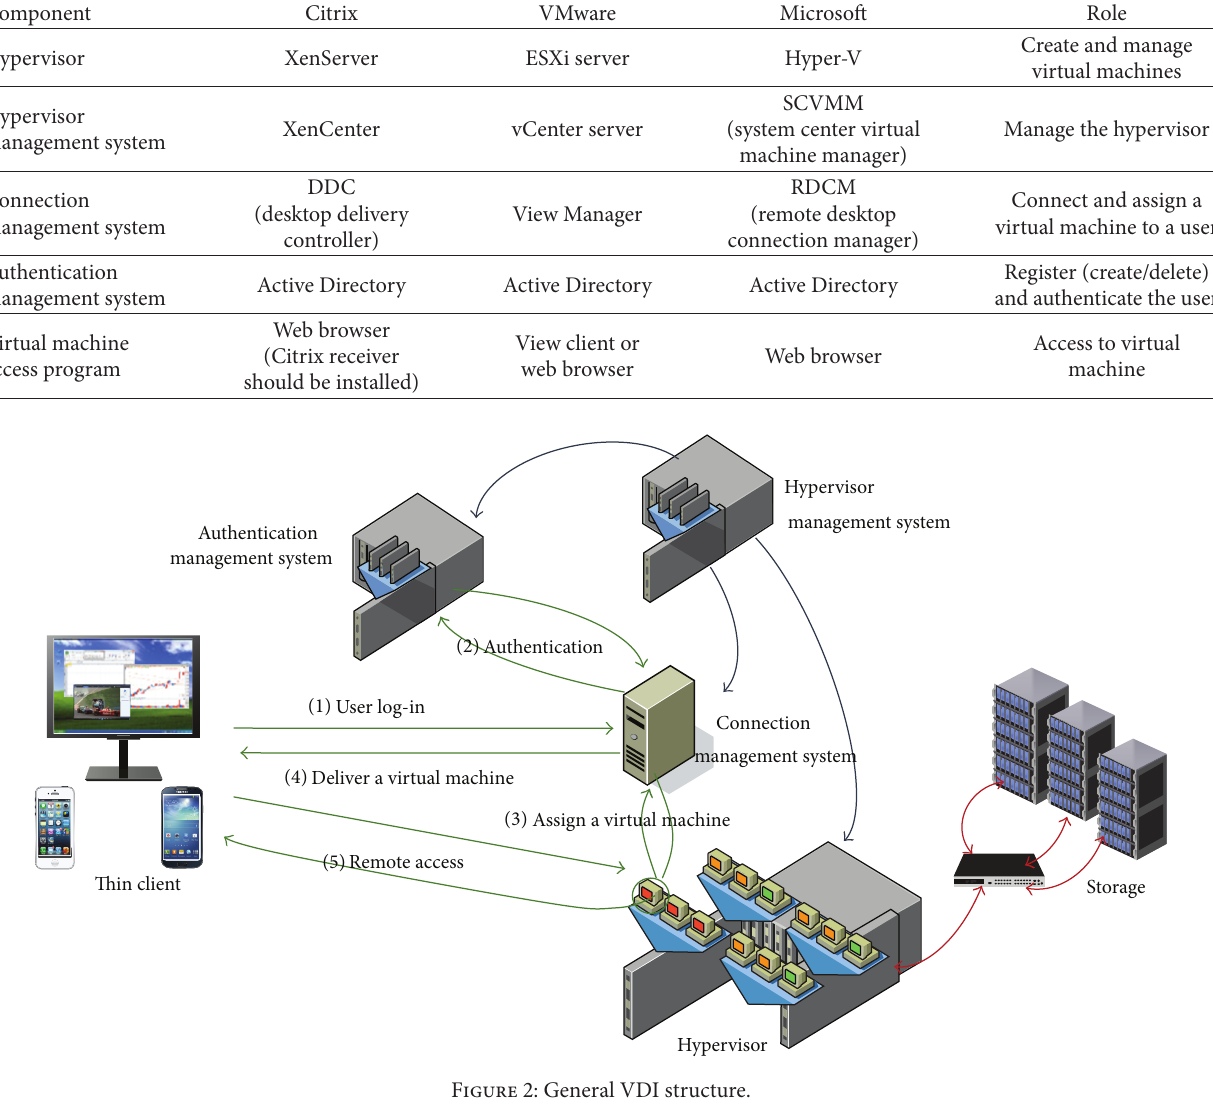
Figure 3. When a user accesses a virtual machine,